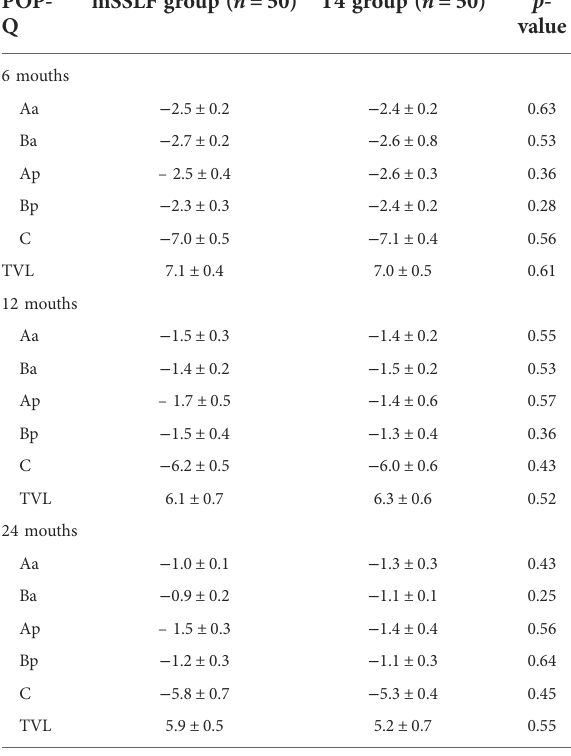
TABLE 3 Anatomic outcomes measured by POP-Q at three timepoints after surgery. a POP- mSSLF group ( n = 50) T4 group ( n = 50) p- Q